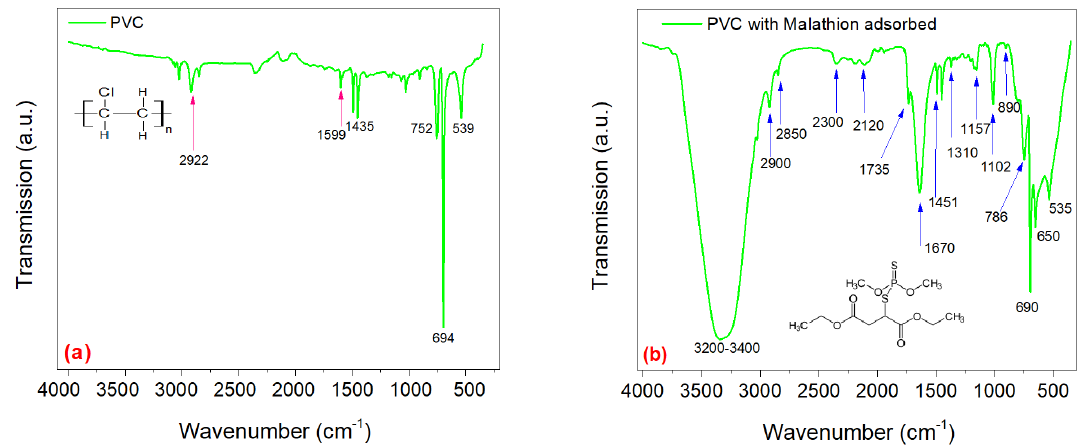
Figure 4. FTIR analysis of PVC before ( a ) and after ( b ) the adsorption